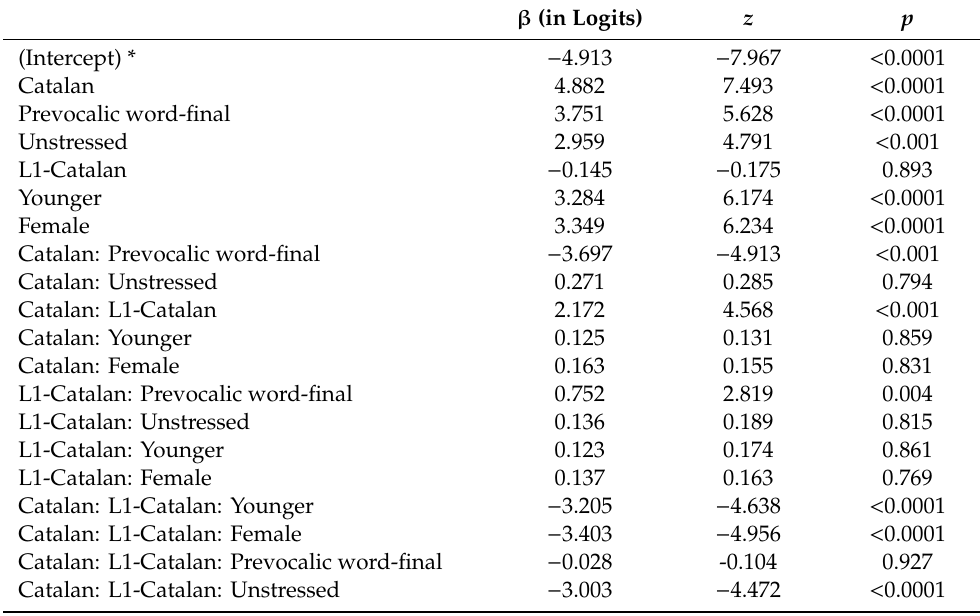
Table 2. Summary of the mixed-e ff ects logistic regression model fitted to Barcelonan fricatives.